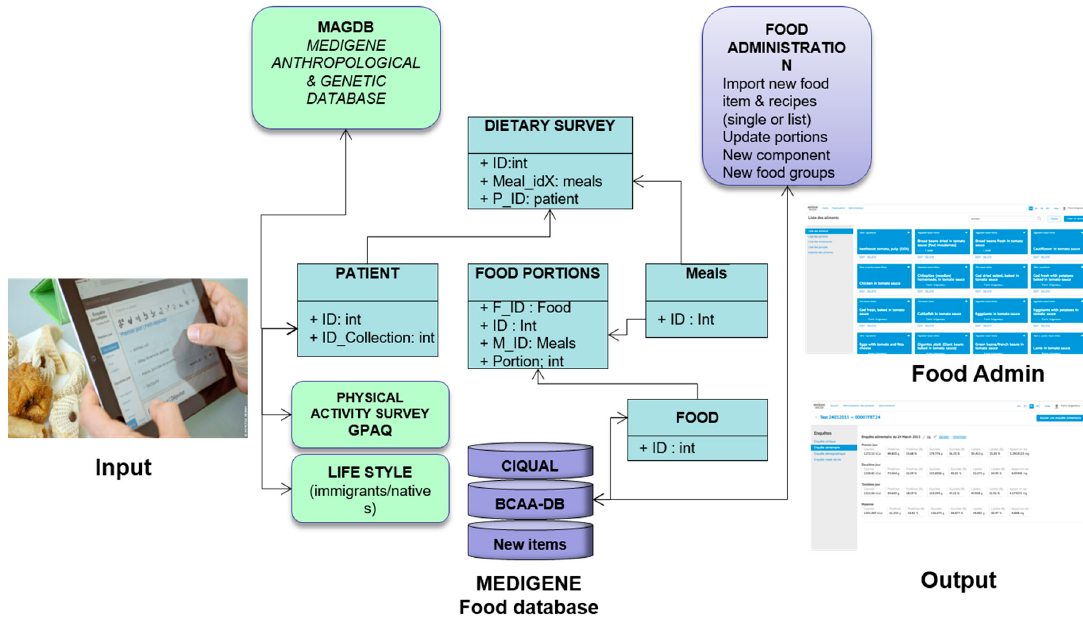
Figure 1. General architecture of MEDIPAD software.